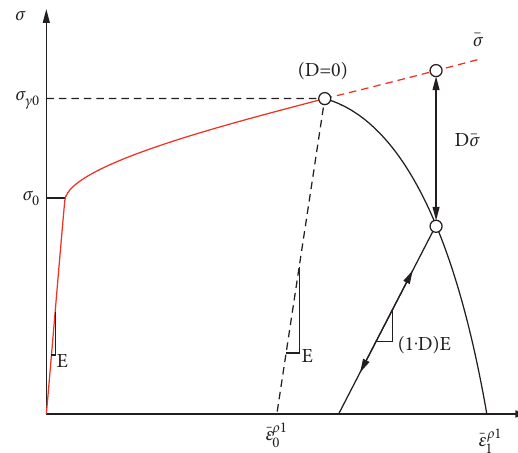
Figure 5: Stress-strain relationship of metallic material.